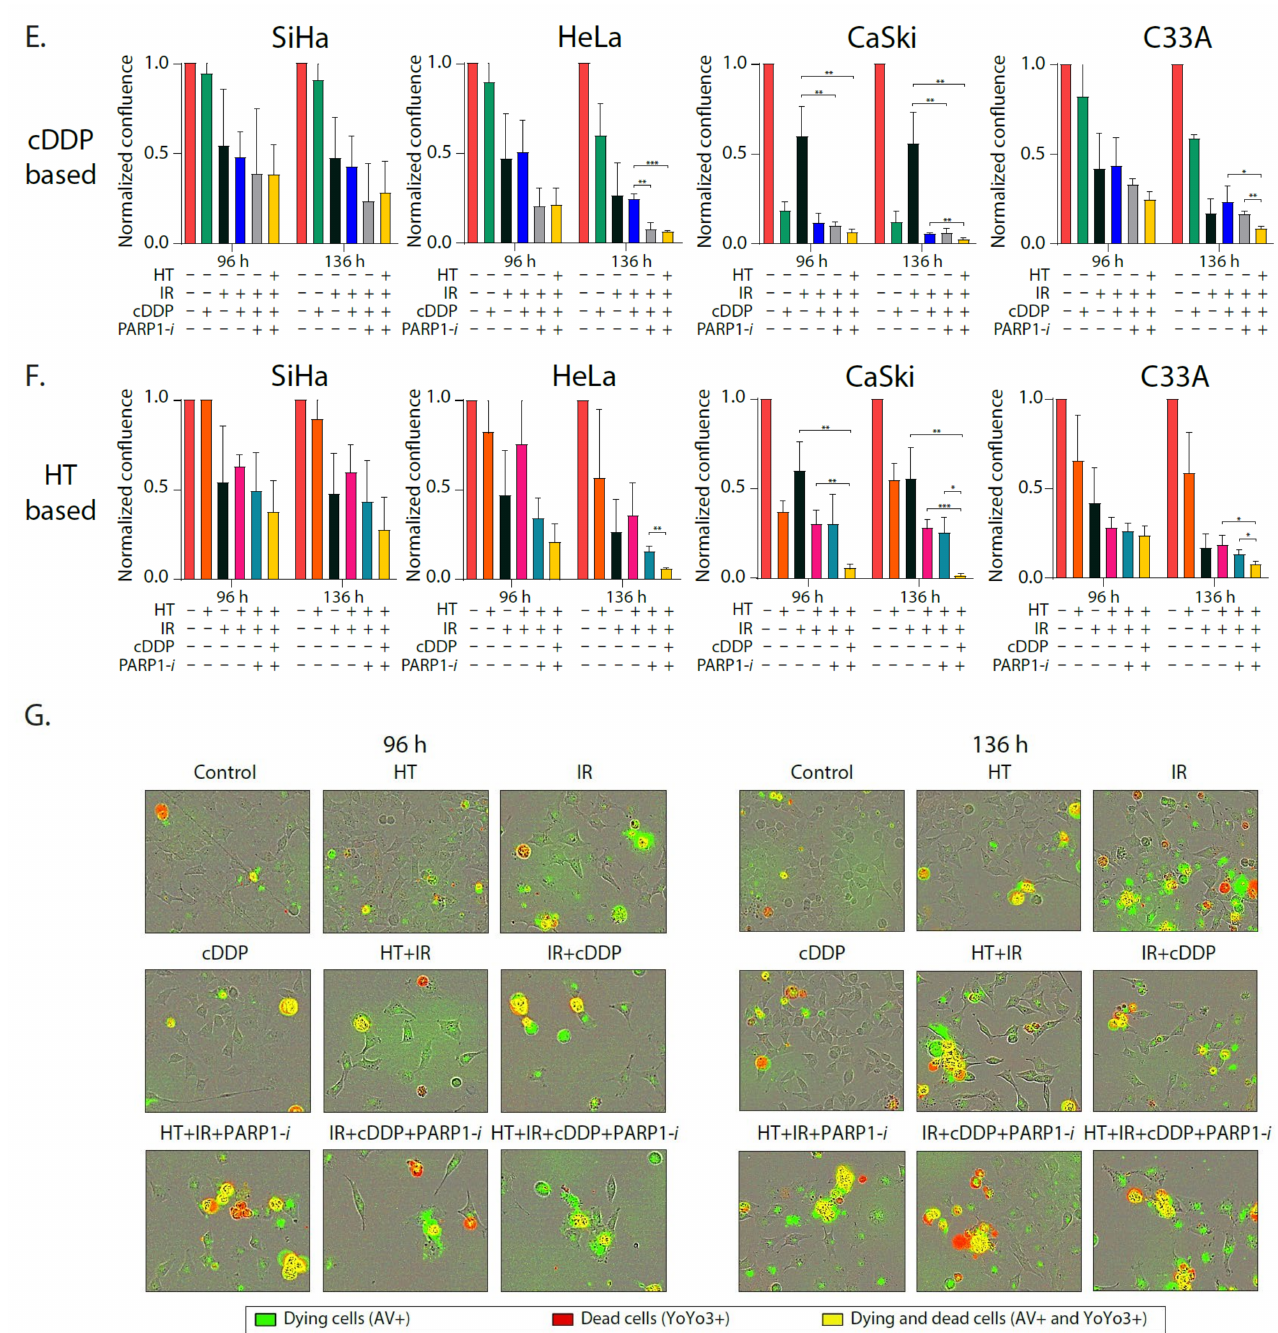
Figure 3. In vitro analysis of dying and dead cells in cervical cancer cell lines SiHa, HeLa, CaSki, and C33A. ( A , B ) Displaying the percentage of dying cells after treatment with 2 Gy ionizing radiation (IR), cisplatin (cDDP), hyperthermia (HT) and PARP1-inhibition (PARP1- i ) in different combinations. ( C , D ) Displaying the percentage of dead cells after treatment with ionizing radiation (IR), cisplatin (cDDP), hyperthermia (HT) and PARP1-inhibition (PARP1-i) in different combinations. ( E , F ) Displaying the confluence per treatment normalized to the control. ( G ) Appearance of dying cells (AV+) and dead cells (YoYo3+) in HeLa cells per treatment at 96 h and 136 h after treatment. * p < 0.05, ** p < 0.01, *** p < 0.001, **** p < 0.0001 compared with corresponding controls, Independent samples t